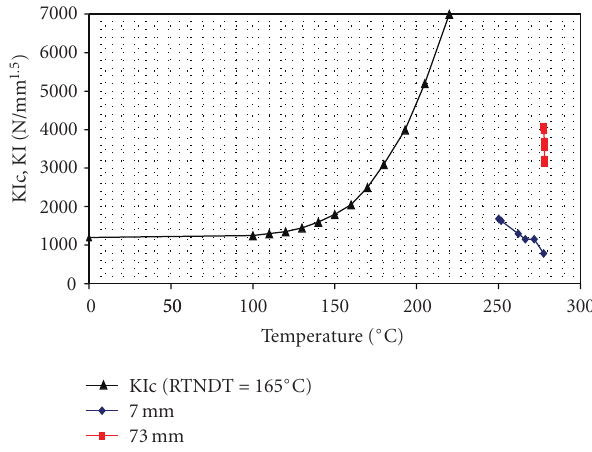
Figure 15: KI and KIc versus